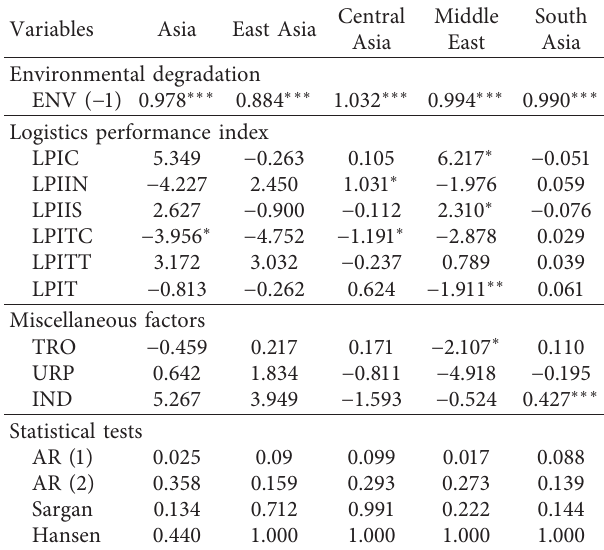
Figure 3: Urbanization and industrialization values in the subregions of Asia (2007–2018). Table 3: System GMM panel estimation regression